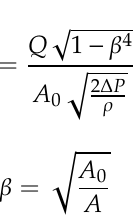
( b ) Figure 9. Variation of (Q2 − Q1)/Q vs. inlet flow rate at different temperatures. ( a ) no rectifier nozzle; ( b ) with rectifier nozzle. 4.2. Effect of Inlet Flow on Flow Distribution Figure 10 shows the difference in the flow distribution of each branch pipe with or without a rectifier nozzle at different inlet flow rates. The horizontal axis is the total flow rate, Q, and the vertical axis is the flow rates Q1 and Q2 of the branch pipe 1 and the branch pipe 2. It can be seen from Figure 10 that the hydraulic distribution of the two branch pipes was uneven because of the “header effect.” The header effect increased with the increase of the inlet flow. This is because the pressure distribution in the branch pipe depends on the mutual conversion between the kinetic and static pressure energy of the fluid in the pipe and the loss of resistance along the flow of the fluid. The flow velocity of the fluid along the main pipeline axis got smaller and smaller, and the flow rate also got smaller and smaller, so that the kinetic energy of the fluid was reduced and the static pressure energy